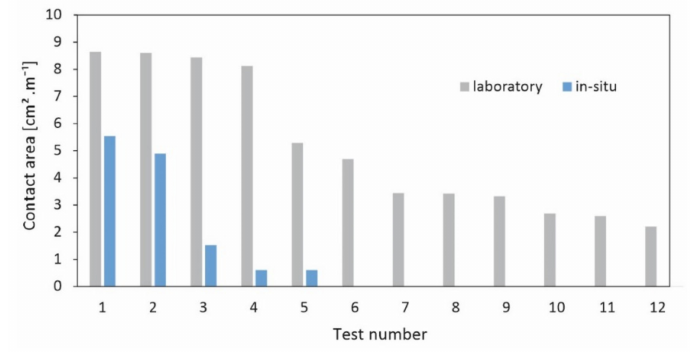
Figure 11. Results of the determination of the contact area between two stones in non-mortared constructions (considering an average stone mass of 1700–2100